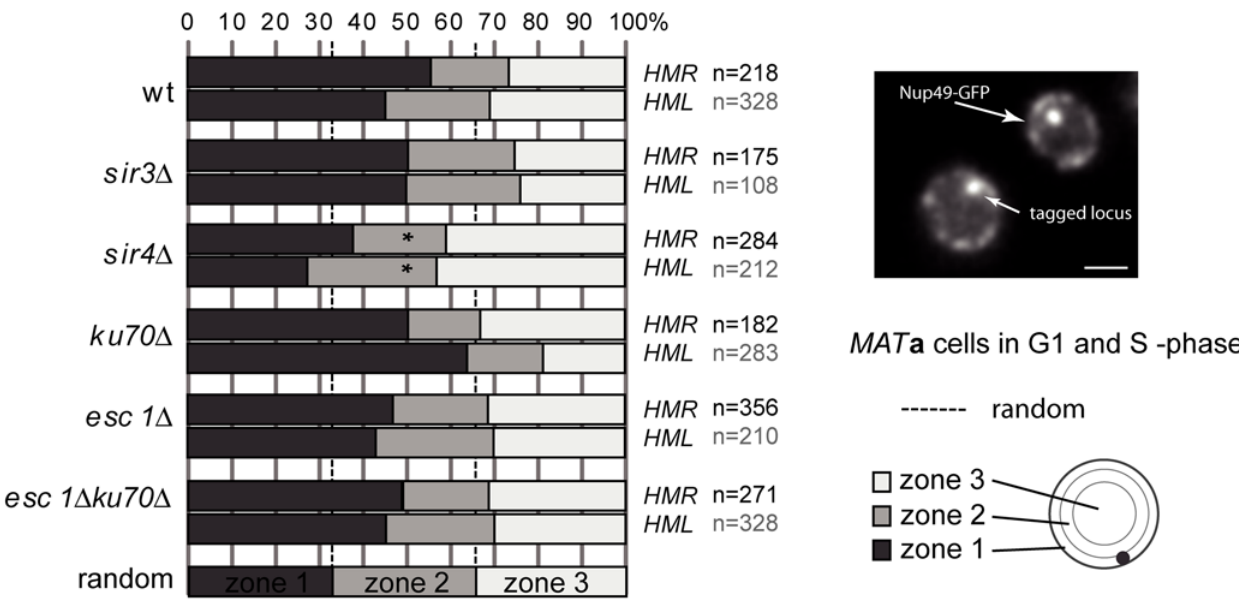
Figure 4. Preferred peripheral position of HML and HMR . Positions were mapped relative to the nuclear envelope in strains of GFP-tagged HML and HMR loci in WT, sir3 D , sir4 D , y ku70 D and esc1 D G1 and S phase MAT a cells. Data are represented in bar graphs as the percentage of spots in 3 concentric zones of equal surface. The number of cells analyzed (n) is indicated. * indicates a distribution identical to random (33% in each zone; P . 0.05) in a x 2 analysis. Bar is 1 m m.